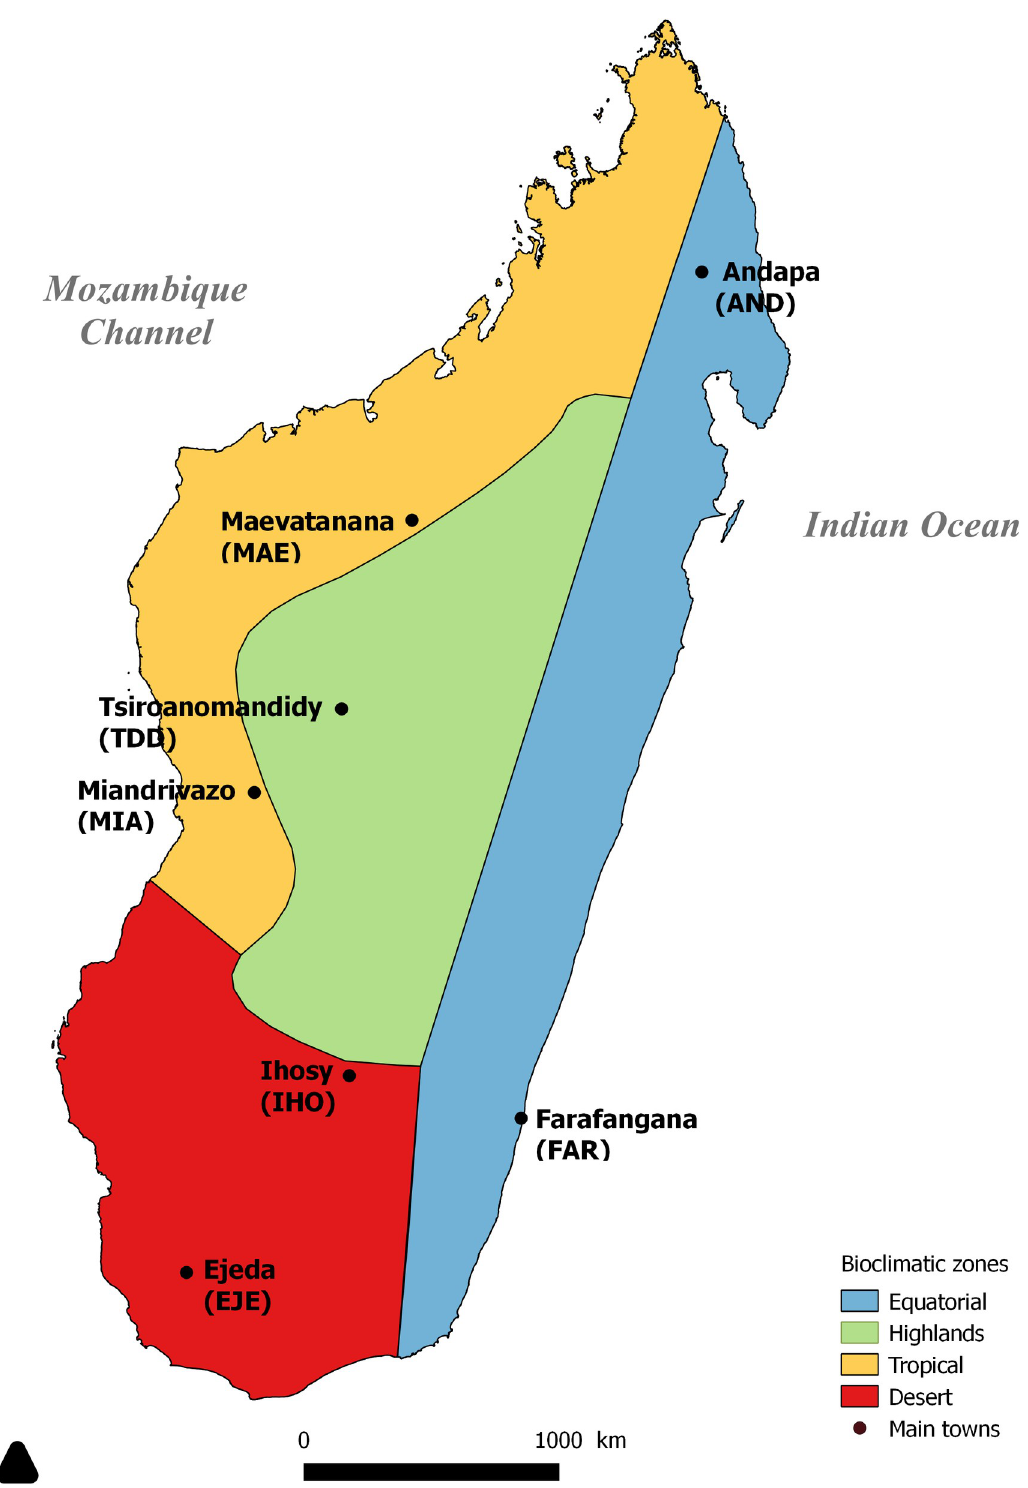
Fig 1. Map of Madagascar indicating bioclimatic zones and major cities including the study sites.